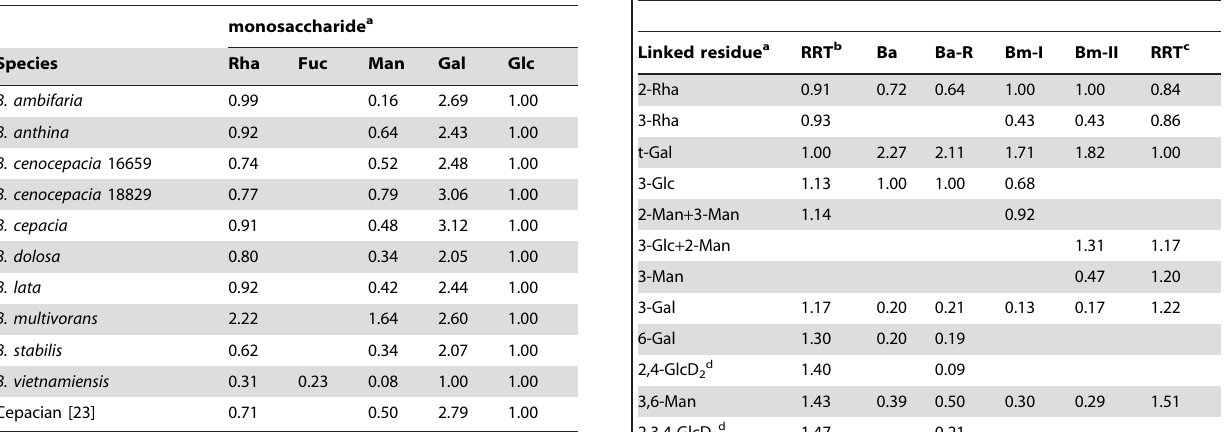
Table 3. Determination of glycosidic linkages in the EPOLs of B. ambifaria before (Ba) and after carboxyl reduction (Ba-R), and B. multivorans C1576 separated on SP2330 (Bm-I) and on HP1 (Bm-II)